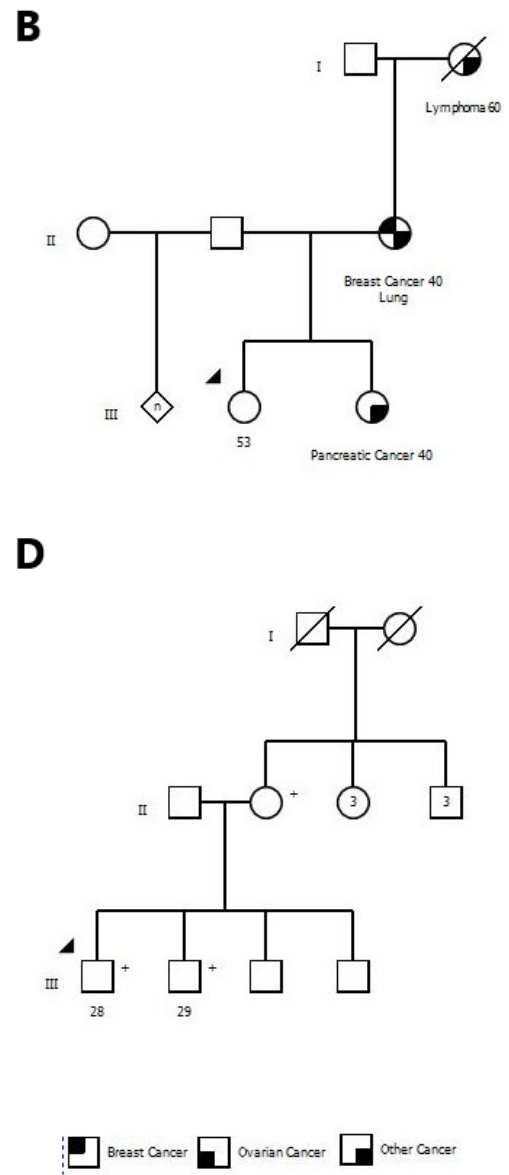
Figure 1. The pedigrees for five BRCA mutation carriers have been shown. ( A ) Proband was denied testing because of not having pathological confirmation of cancers in her family members. ( B ) Proband was denied testing based on local testing criteria. ( C ) Proband was qualified for testing under healthcare system, however, she decided to do the testing through the Screen Project because of ease of access. ( D ) Testing was ordered by the mother who was a known BRCA mutation carrier for her two adult sons, and both were positive. (+) sign denotes mutation carriers.